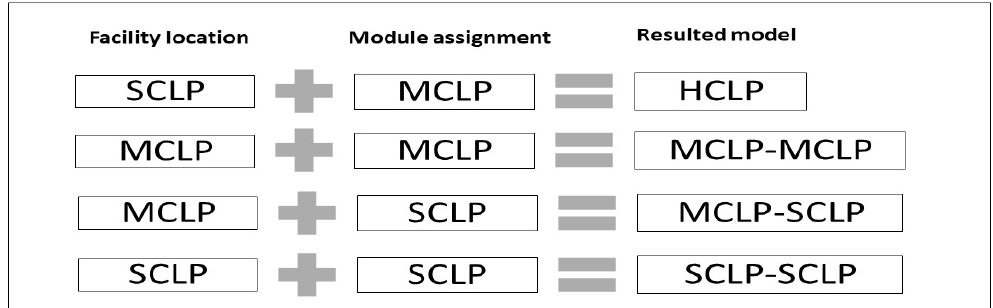
Figure 2. The structure of different possible hybridization models. SCLP: set covering location problem, MCLP: maximal covering location problem, and HCLP: hybrid covering location problem.